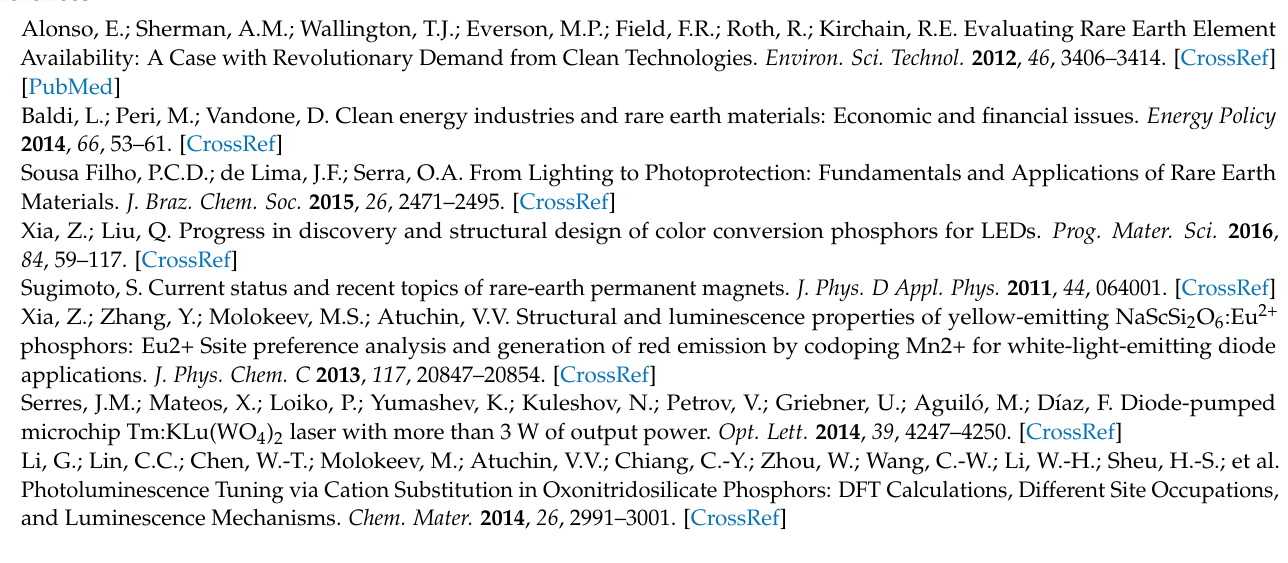
C/min); Figure S10: Linearity in the manifestation of the maxima of thermal effects depending on the heating rate Table S1: Fractional atomic coordinates and isotropic displacement parameters (Å 2 ) in Pr 2 (SO 4 ) 3 ; Table S2: Main bond lengths (Å) in Pr 2 (SO 4 ) 3 ; Table S3: Main parameters of processing and refinement of the Pr 2 (SO 4 ) 3 sample at T = 30–270 ◦ C; Table S4: Fractional atomic coordinates (Å) and occupancies of Pr 2 (SO 4 ) 3 · 8H 2 O; Table S5: Main bond lengths (Å) in Pr 2 (SO 4 ) 3 · 8H 2